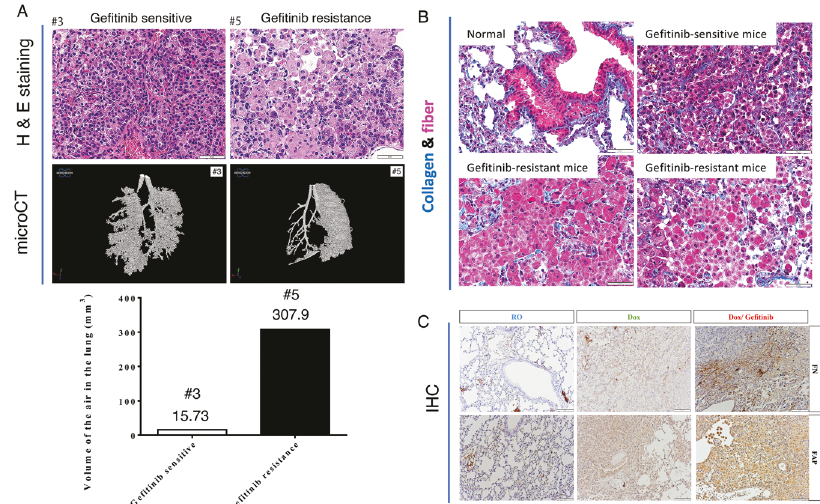
Fig. 2 The extracellular matrix around the tumor was monitored during drug resistance acquisition. The lung pathology in ge fi tinib- sensitive (#3 mice) and ge fi tinib-resistant mice (#5 mice) was studied by H&E staining and 3D micro-CT, and then quantitated by CTAn and CTVol software ( A ). The levels of collagen and fi bers in the lungs of normal mice ( n = 3), Ge fi tinib-sensitive mice ( n = 3) and Ge fi tinib-resistant mice ( n = 6) were studied by Masson ’ s trichrome staining, blue: collagen; pink: fi bers; red: cytoplasm ( B ). The levels of fi broblast markers, FN and FAP, were studied by IHC with indicated antibodies ( C Different mutational hotspot regions are found during tumorigenesis and in mice with drug-resistant lung cancer Because heterogeneity is a critical factor for inducing drug resistance, genomic DNA was extracted from the lungs of ge fi tinib-sensitive and ge fi tinib-resistant mice for whole genomic sequencing (WGS) (Fig. 2A). The sequencing quality control and error rate were reasonable and are shown in the supplementary results (Supplementary Fig. 1). All the sequences were compared to the whole-genome of wild-type mice in GRCm38 genome (ftp:// by WGS in ge fi tinib-resistant mice (201829 bps) was higher than that in ge fi tinib-sensitive mice (194258 bps) (Fig. 2A and Table 1). Analysis of the mutant distribution of mutations across the chromosomes showed that hotspot mutations in ge fi tinib-sensitive mice (tumorigenesis) were found on chromosome 1 (Chr.1qE2.1:4.9 cM – Chr.1qG1:63.5 cM)